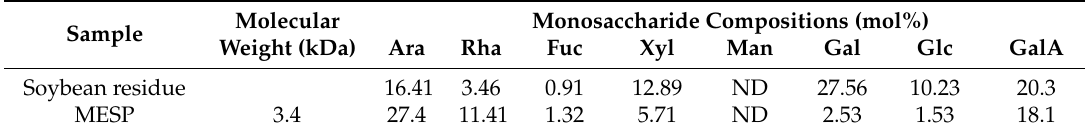
Figure 1. Elution curve obtained using Sephadex G-75 gel filtration ( a ) and HPLC chromatograms ( b ). Gas chromatography (GC) analysis of the monosaccharides (Table 1) revealed that MESP comprised arabinose, galacturonic acid, rhamnose, xylose, galactose, glucose, and fucose at a molar ratio of 27.4:18.1:11.41:5.71:2.53:1.53:1.32, indicating that arabinose, galacturonic acid, and rhamnose were the main monosaccharide components of low molecular weight soluble polysaccharides (MESP). Table 1. Monosaccharide composition of okara polysaccharide.